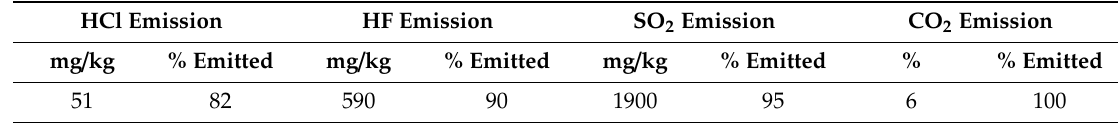
Table 4. Emission values at 1200 ° C.